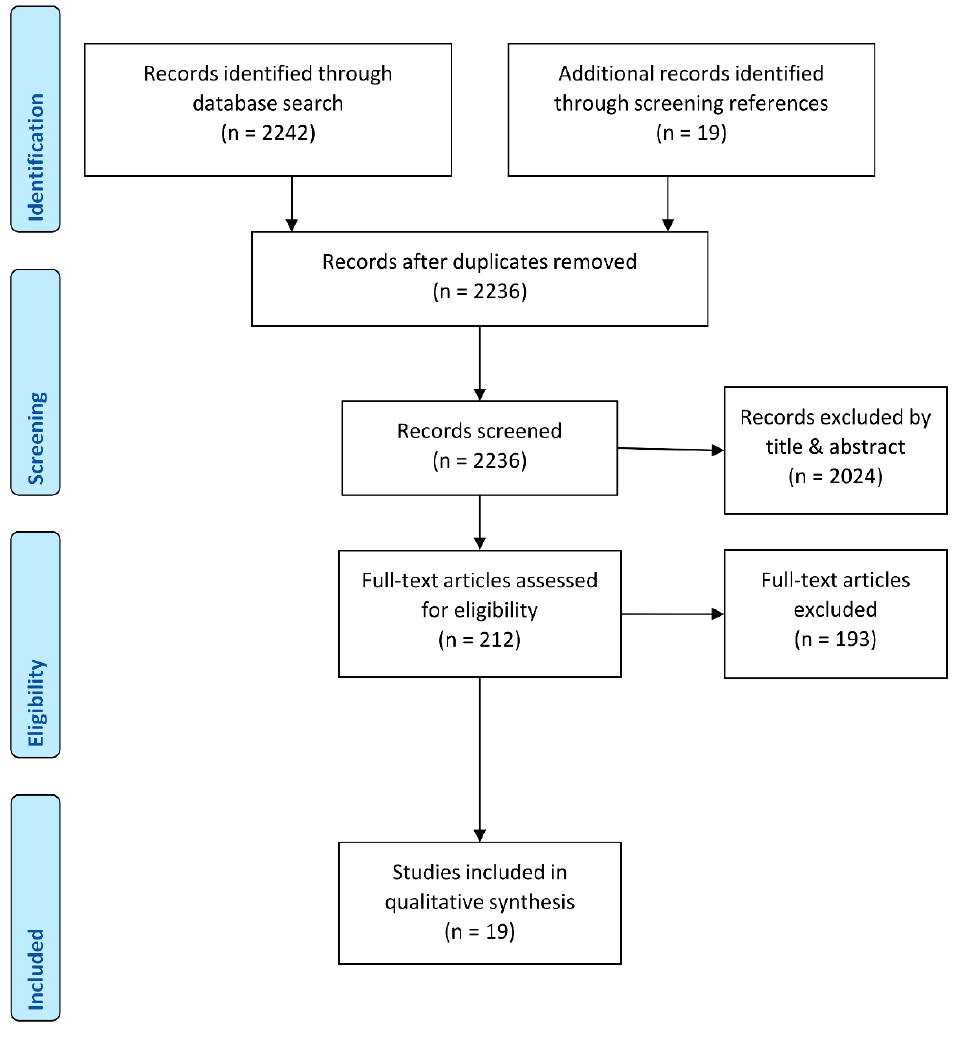
Figure 1. PRISMA flowchart of the article selection process (Modified from Moher et al. [20]).